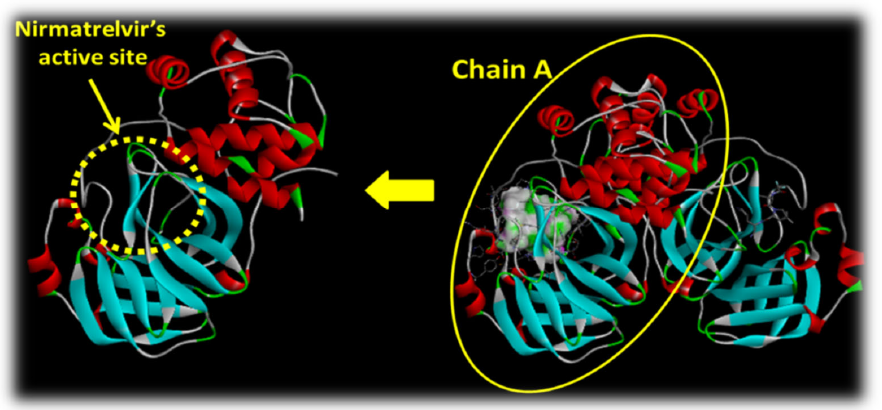
Figure 2. ( Right ): the structure of SARS ‐ CoV ‐ 2 M pro Omicron P132H in complex with nirmatrelvir. ( Left ): chain A of main protease enzyme. ( Left ): chain A of main protease